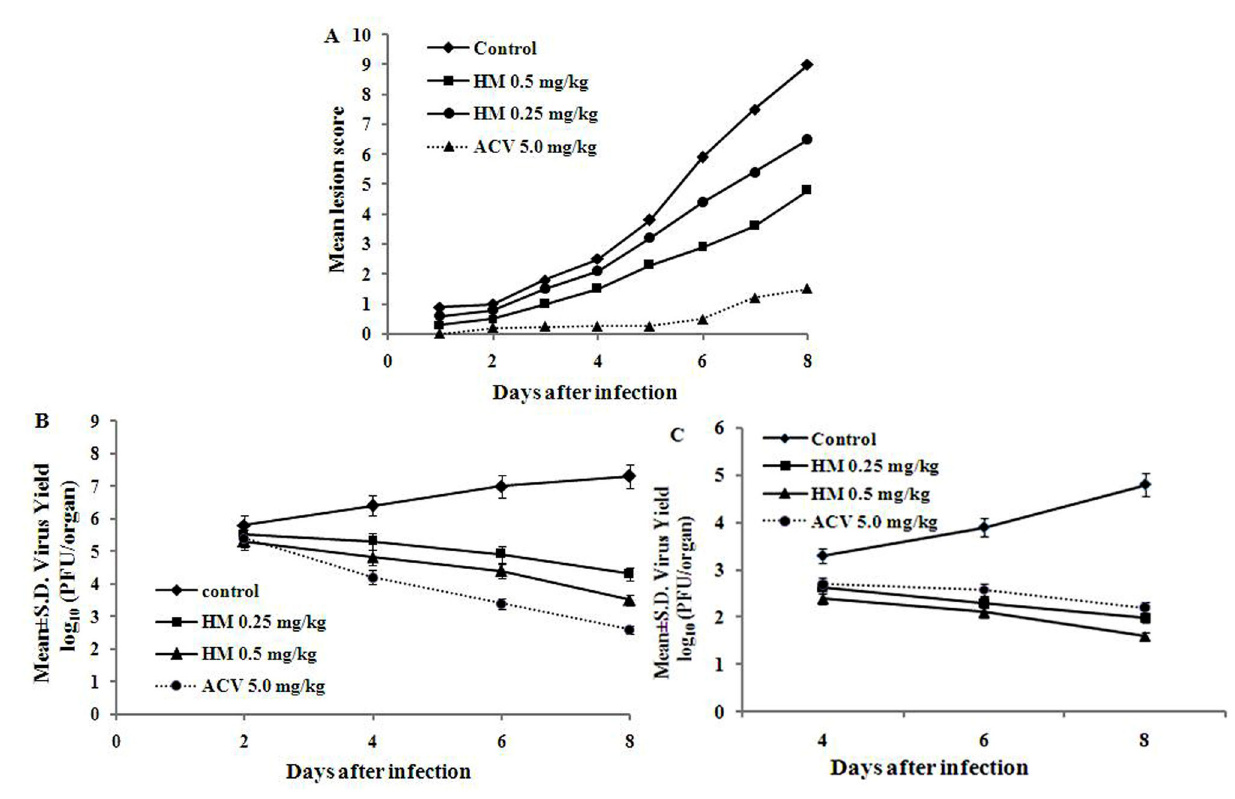
Figure 6. In vivo efficacy of. HM. BALB/c mice were fed with HM (0.25 or 0.5 mg/kg) or ACV (5 mg/kg) and after 8 h of drug treatment the animals were infected with HSV-2G (9 X 10 5 pfu per animal) intravaginally. The challenged animals of test groups were fed with HM twice daily for 7 days. Development of lesions and death were observed three times daily, while brain and vaginal tissue were collected after sacrification on days 2, 4, 6 or 8 after infection, homogenized and centrifuged. The supernatant was used for the determination of virus yield by plaque assay. Mean lesion score [A], Mean±S.D. of virus yield at log tissue [B] and brain